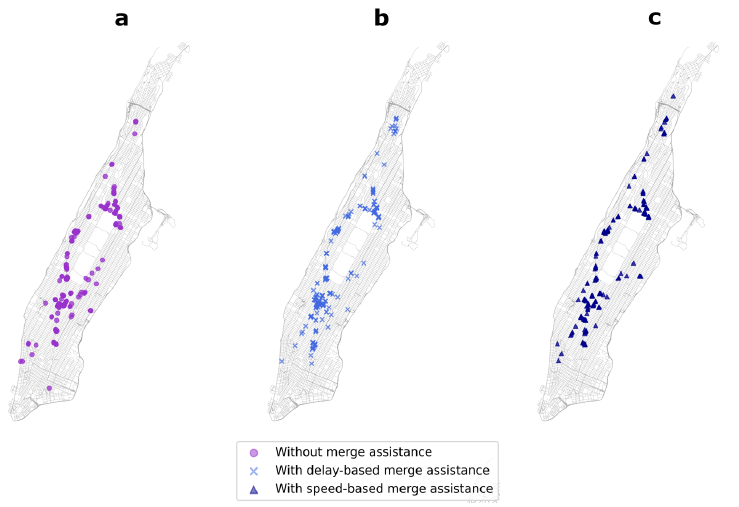
Figure 8. Here, ( a – c ) geographical location of pairwise intrusions that relate to without merge assistance, with delay-based merge assistance and with speed-based merge assistance with respect to the high traffic density scenario. Colours are used to distinguish the different pairwise intrusion categories: without merge assistance marked in purple ( a ), delay-based merge intrusions represented by the blue crosses ( b ), and the speed-based merge intrusions marked by the blue triangles ( c ). The overlaid intrusions from the different merge assist policies indicated by the darker hotspot zones demonstrate that some intrusions remain